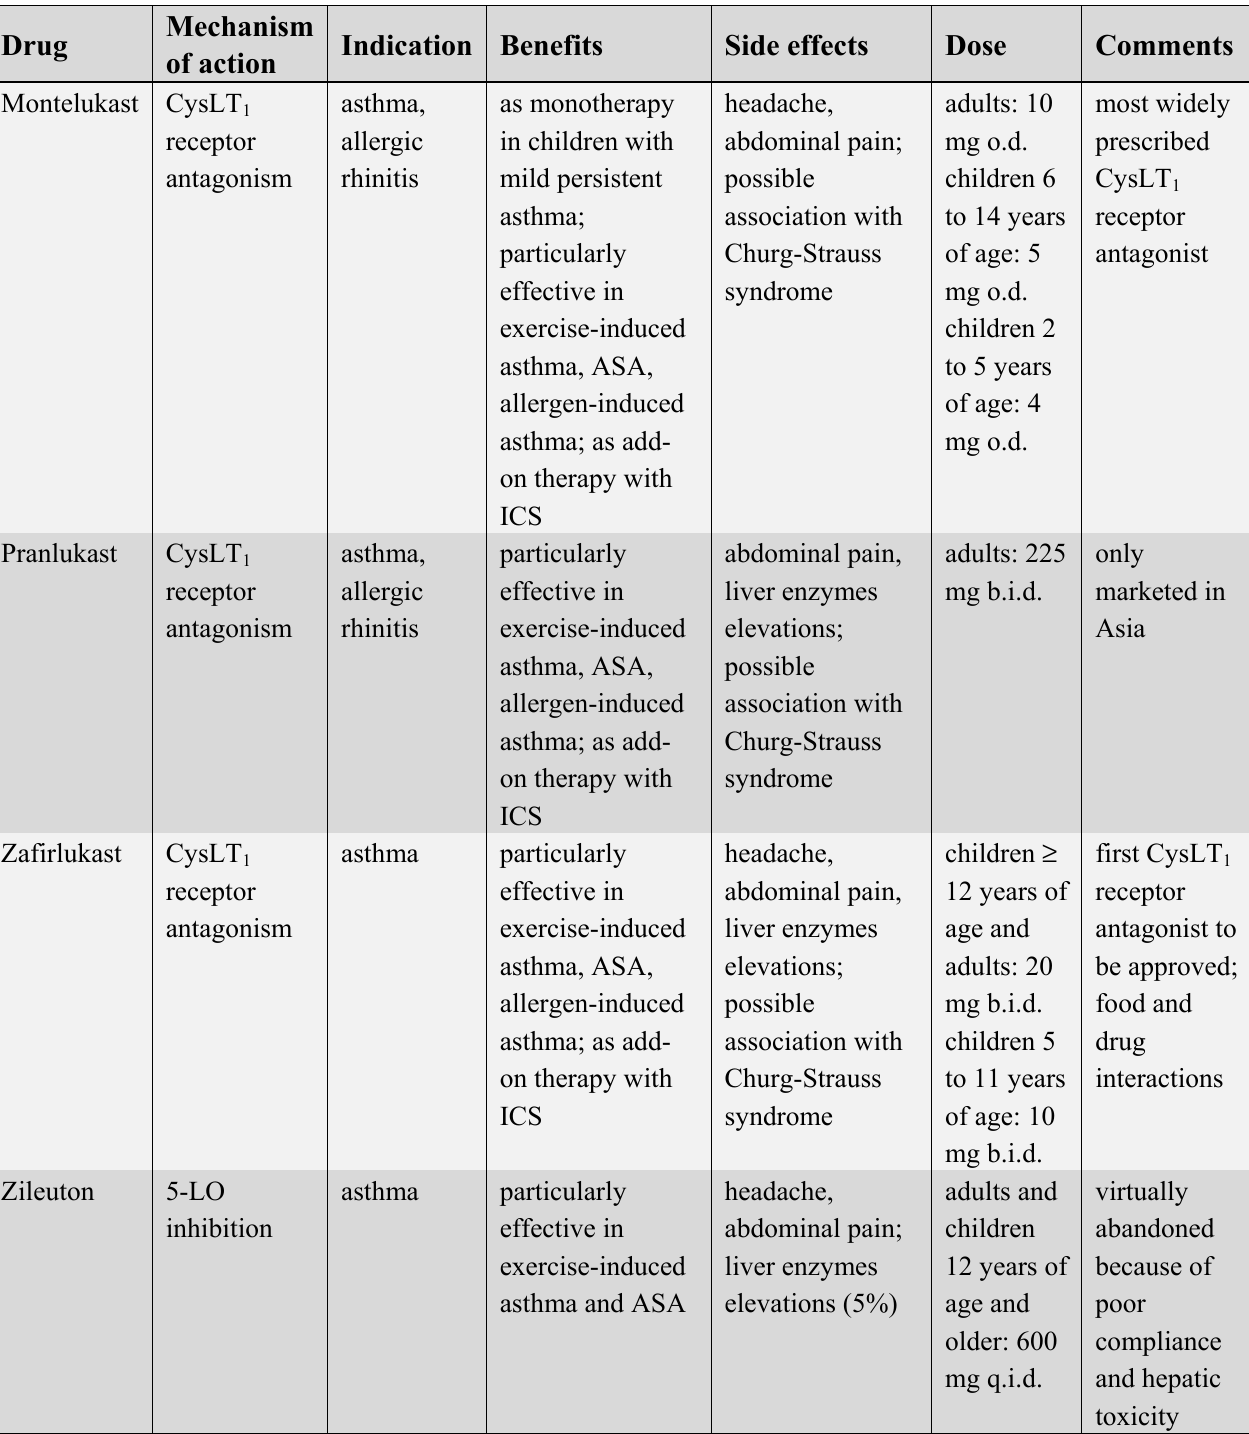
Table 1. Main pharmacological characteristics of antileukotrienes (reproduced with permission from reference